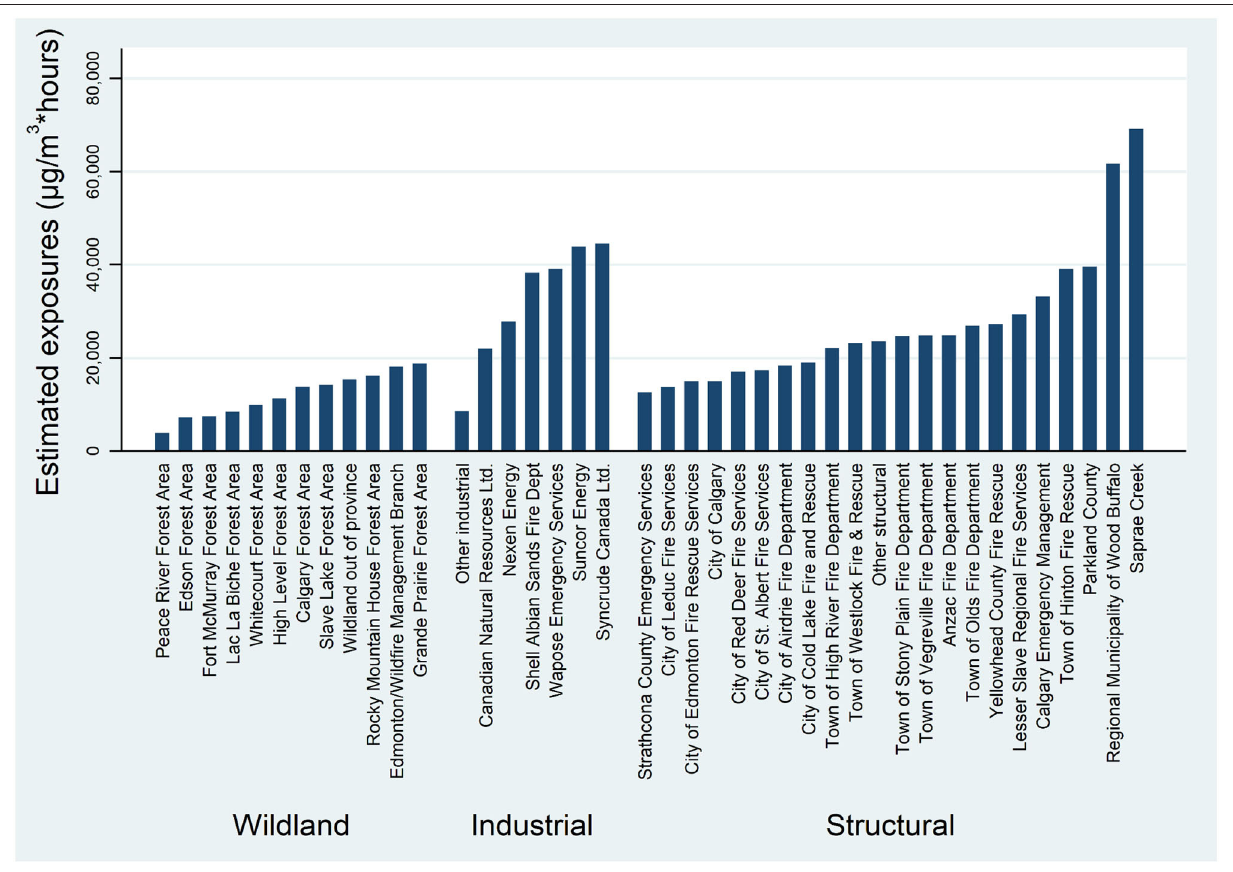
and partitioning out estimated exposure and the use of